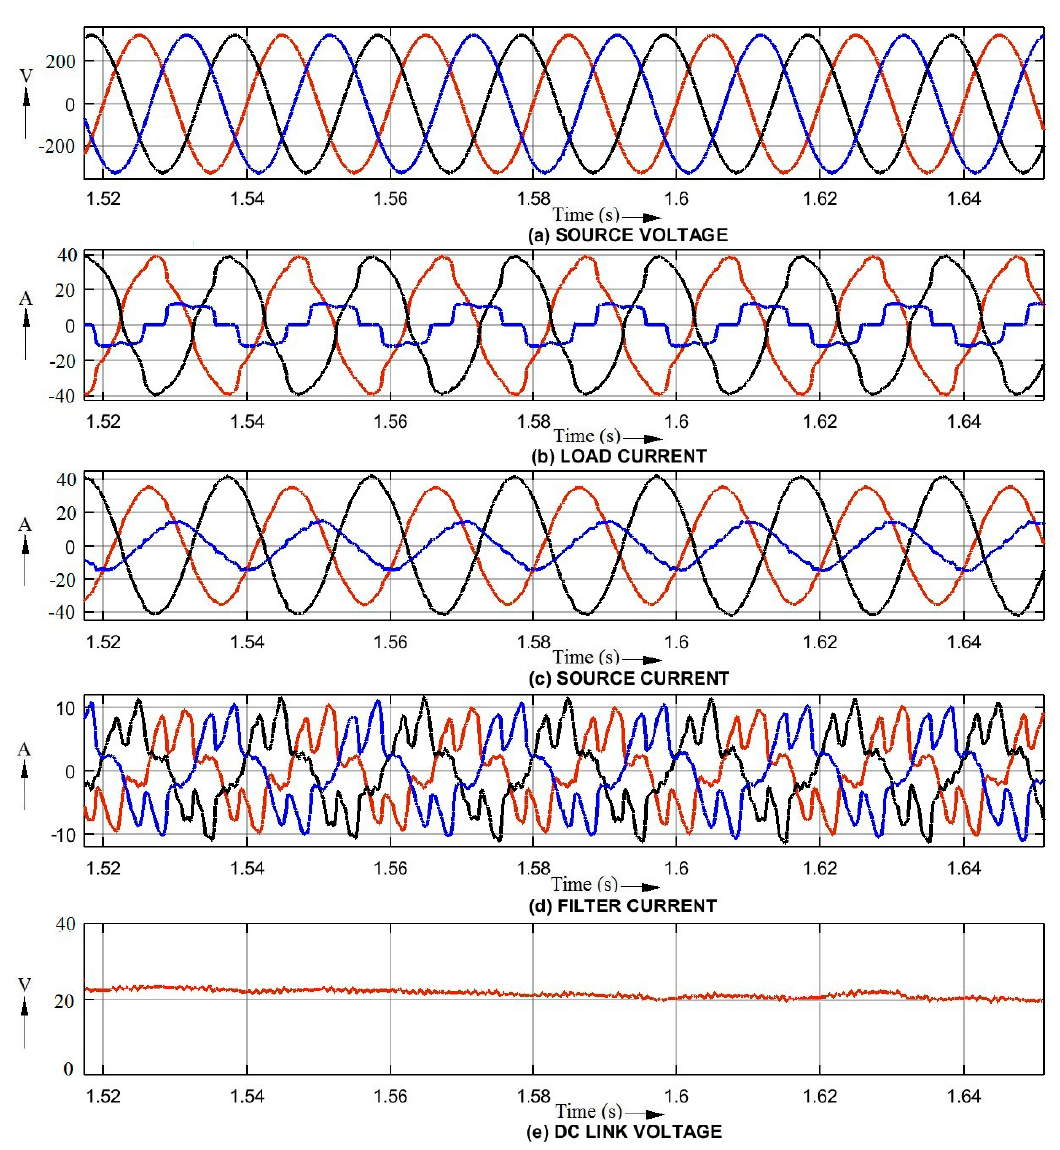
Figure 10. Performance of the compensator to the unbalanced nonlinear load.